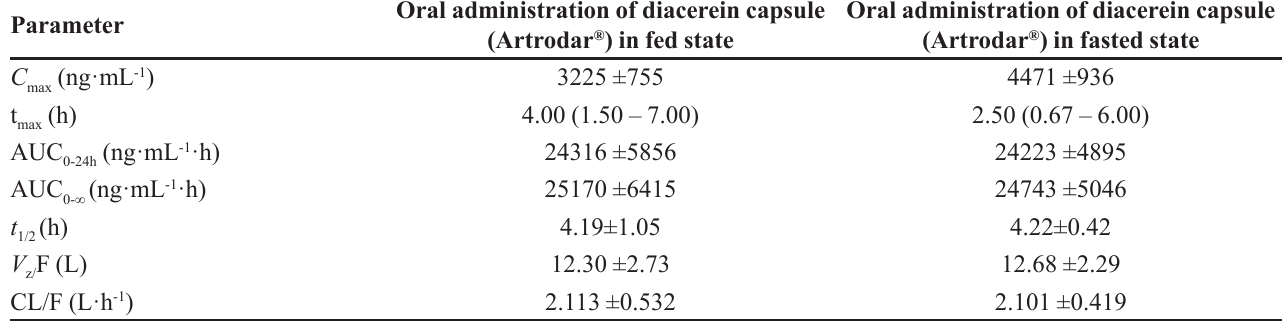
TABLE II - Main pharmacokinetic parameters of rhein after oral administration of 50 mg dose of diacerein capsule (Artrodar ® ) in